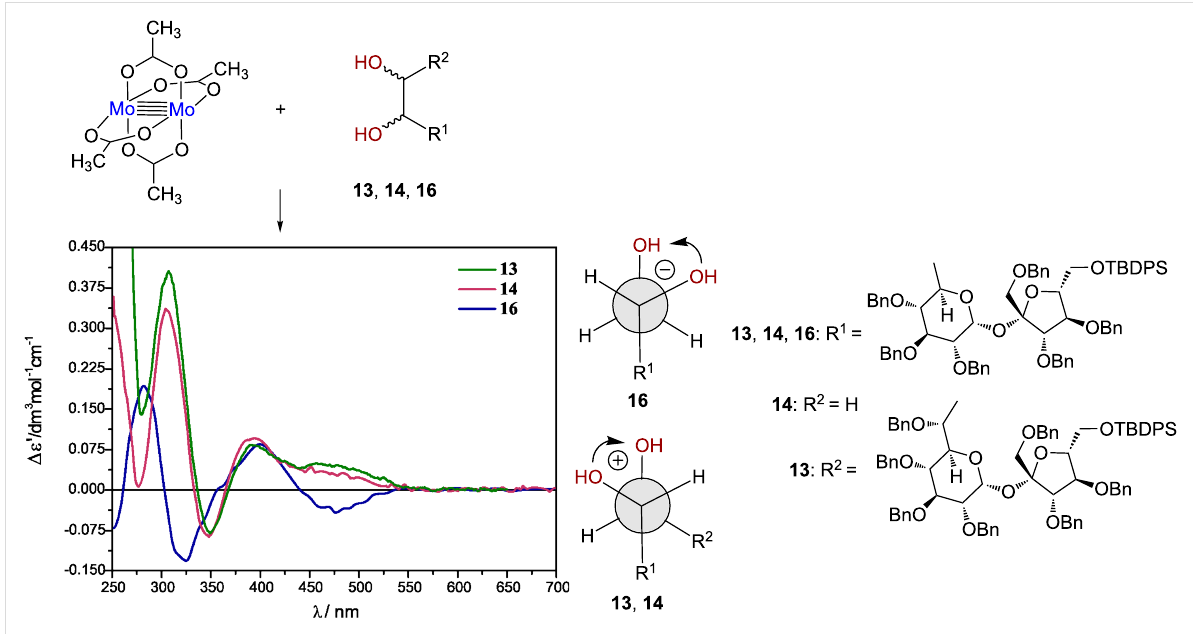
Figure 3: CD spectra of in situ formed chiral complexes of 13 (green line), 14 (purple line) and 16 (blue line) with dimolybdenum tetraacetate recorded in DMSO; right: preferred gauche conformation of the diols 13 , 14 and 16 in the complex with Mo 2 -core.